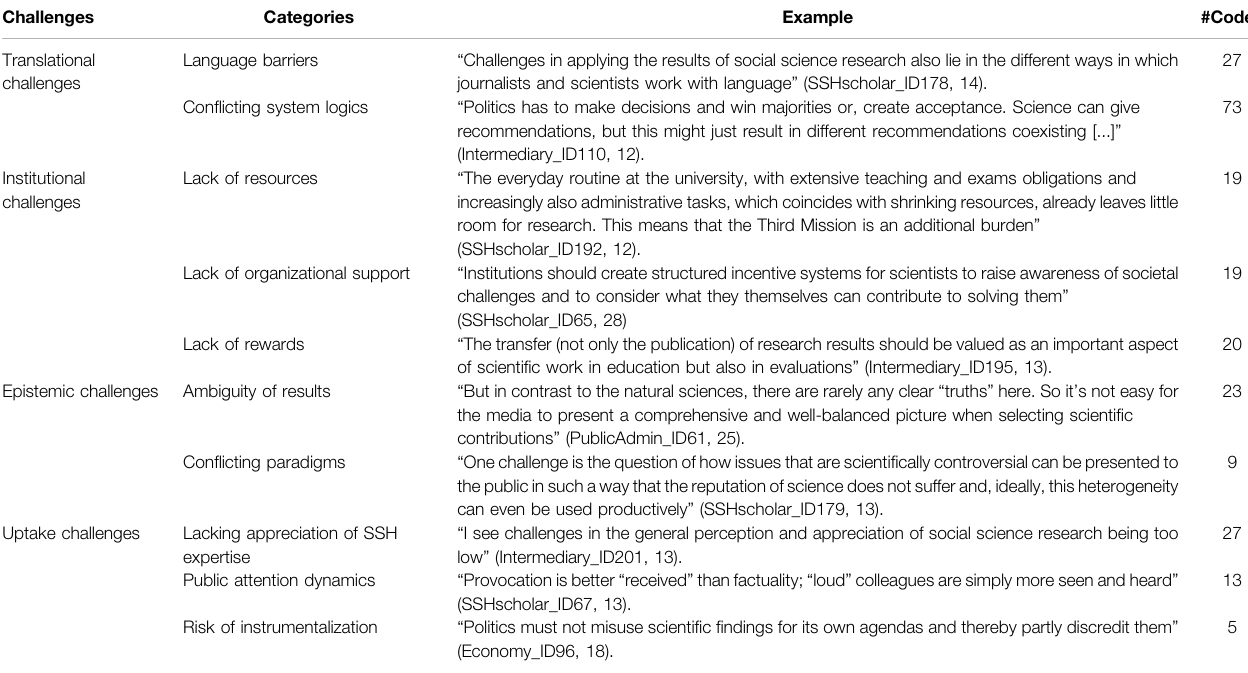
TABLE 4 | Interaction